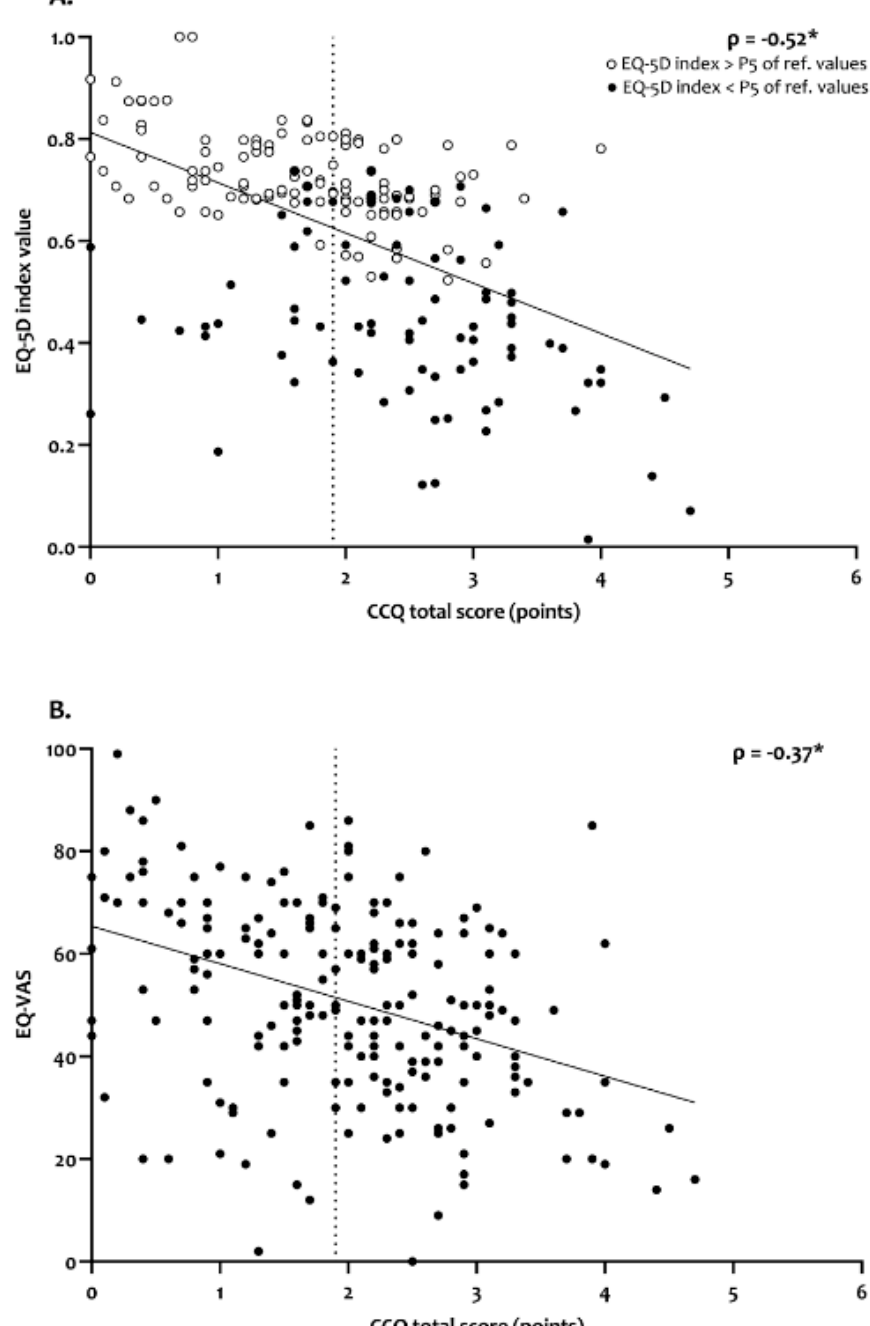
Figure 3. Association between EQ-5D index scores ( A ) and EQ-VAS scores ( B ) with CCQ total scores. Spearman’s rank correlation ρ is presented for both associations. On the horizontal axis, the CCQ total score cut off of 1.9 points is displayed [15]. * = p < 0.001. Abbreviations: EQ-5D-5L = five-level EQ-5D; VAS = visual analogue scale; P5 = fifth percentile; CCQ = Clinical COPD Questionnaire.